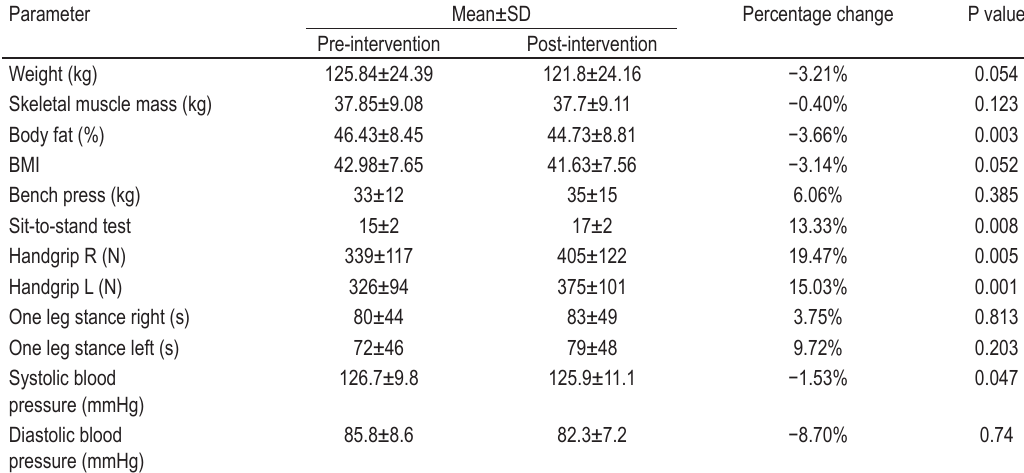
TABLE 4. The influence of 10‑week training program on physical ability parameters in participants before and after the